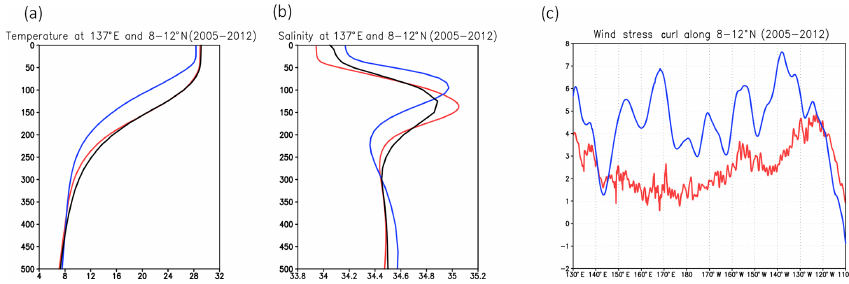
Figure 8. Vertical profile of (a) temperature ( ◦ C) and (b) salinity (psu) at 137 ◦ E averaged from 8 to 12 ◦ N and over 2005–2012. (c) Longi- tudinal distributions of the wind stress curl (10 − 8 Nm − 3 ) along 10 ◦ N (averaged from 8 to 12 ◦ N and over 2005–2012). The red, blue, and black curves are OFES2 driven by JRA55-do, OFES driven by the NCEP reanalysis, and the WOA13 observations,